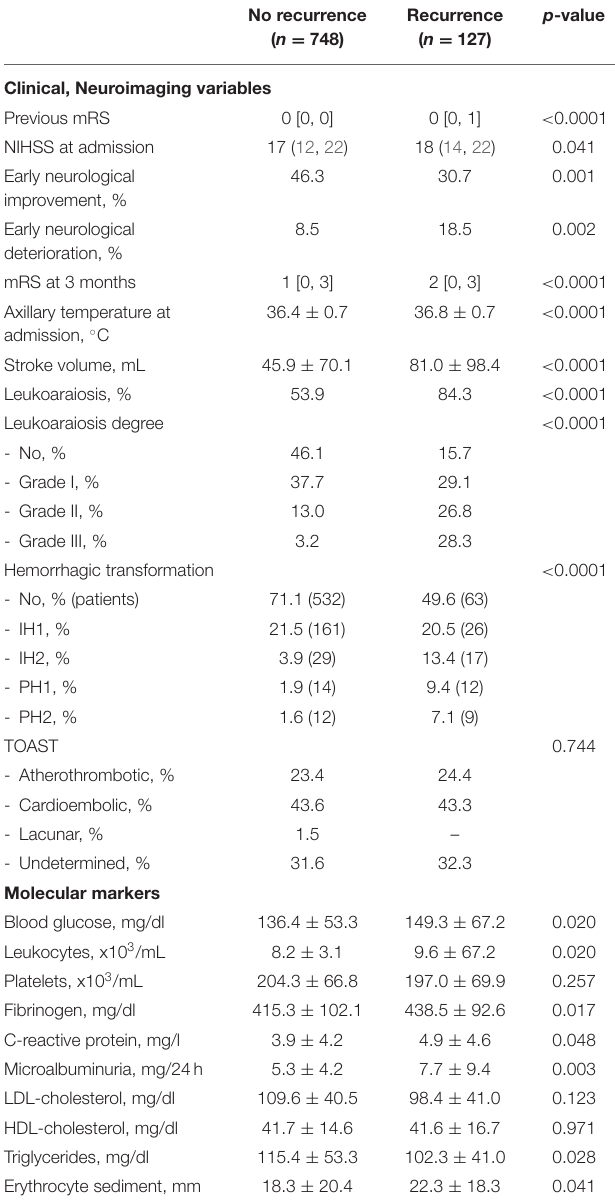
TABLE 2 | Univariate analysis of clinical, neuroimaging variables, and molecular markers obtained in the first admission among patients who presented or not a stroke recurrence ( n =